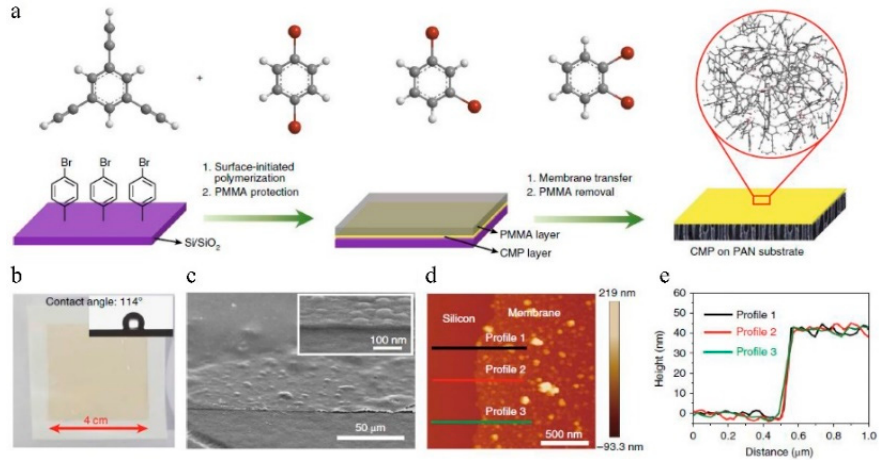
Figure 18. Preparation and characterization of all-conjugated CMP membranes with various dibromobenzene monomers, and investigation of their mechanical properties. ( a ) Surface-initiated polymerization of the CMP membrane on a bromobenzene-functionalized Si/SiO2 substrate. A Sonogashira–Hagihara reaction between 1,3,5-triethynylbenzene (1,3,5-TEB) and three different dibromobenzenes (whose structures are shown at the top) were adopted because it includes highly cross-linked and all-conjugated porous polymers. The bromine sites on the Si/SiO2 substrate (bottom left) acted as the initial reaction sites. The dibromo-monomers were used: 1,4-dibromobenzene, 1,3-dibromobenzene, and 1,2-dibromobenzene. Atoms color code: C, grey, H, white, and Br, red. The bottom panel shows a schematic representation of the surface-initiated polymerization. The inset in the red circle (right) shows the all-rigid skeleton of the resulting CMP membrane. ( b ) Photograph of an approximately 42 nm-thick p-CMP membrane transferred to a PAN substrate. The contact angle is 114° (inset), which indicates the hydrophobic nature of this membrane. ( c ) Large-area surface and cross-section (inset) SEM images of the CMP membrane after transferring it to a silicon substrate. ( d , e ) AFM image ( d ) and corresponding height profile ( e ) of a p-CMP membrane on top of a silicon wafer. A scratch was made to expose the wafer surface, which allowed for the measurement of the height from the silicon wafer surface to the upper membrane surface. Reproduced from Reference [88].